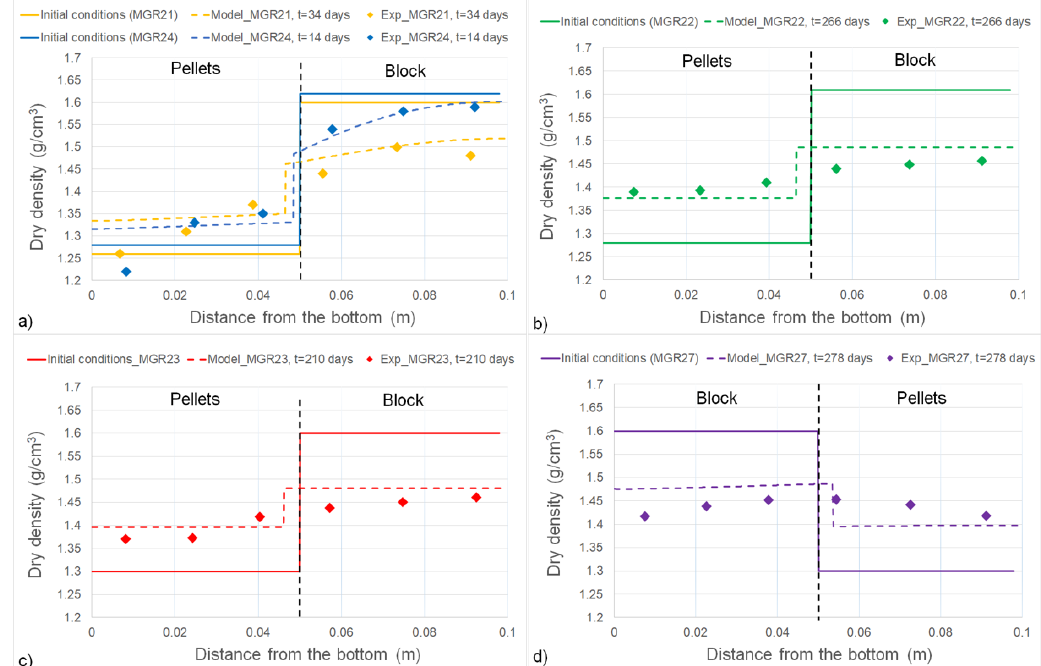
Figure 8. Comparison of modeling results (dashed lines) and measurements (experimental points) of dry density distribution along the height of the samples ( a ) MGR21 and MGR24 after 34 and 14 days, respectively; ( b ) MGR22 after 266 days; ( c ) MGR23 after 210 days; ( d ) MGR27 after 278